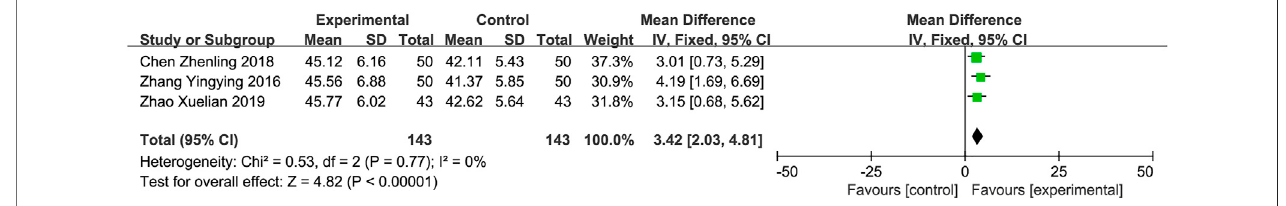
FIGURE 7 | Forest plot of stroke volume.